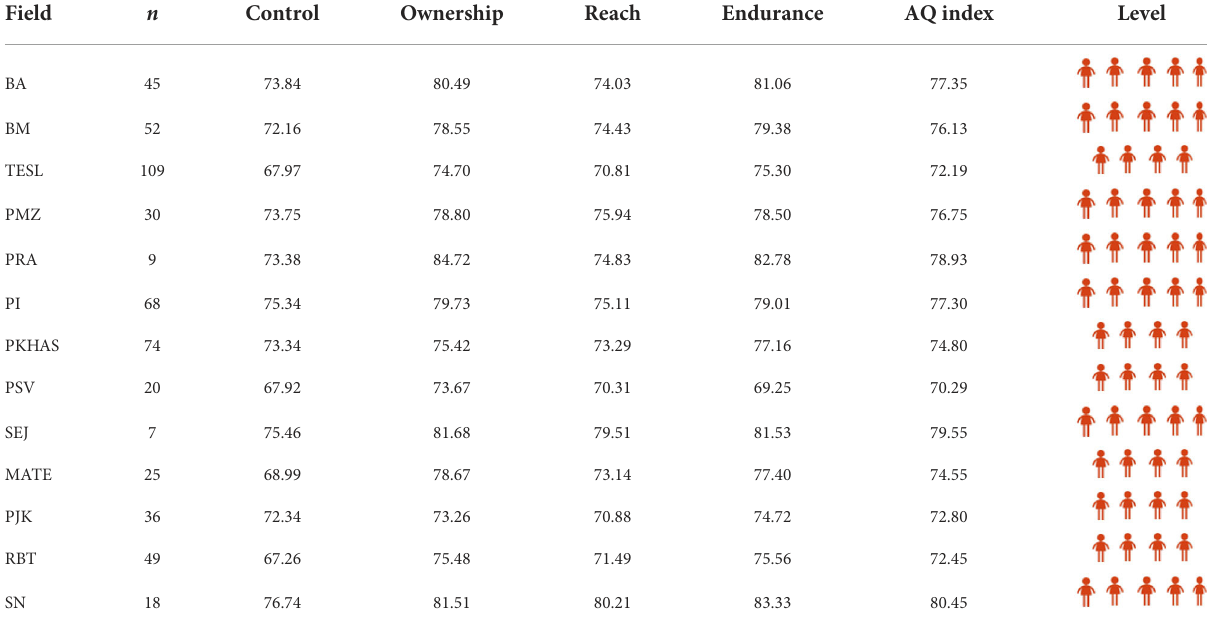
TABLE 13 AQ profile of pre-service teachers based on field of